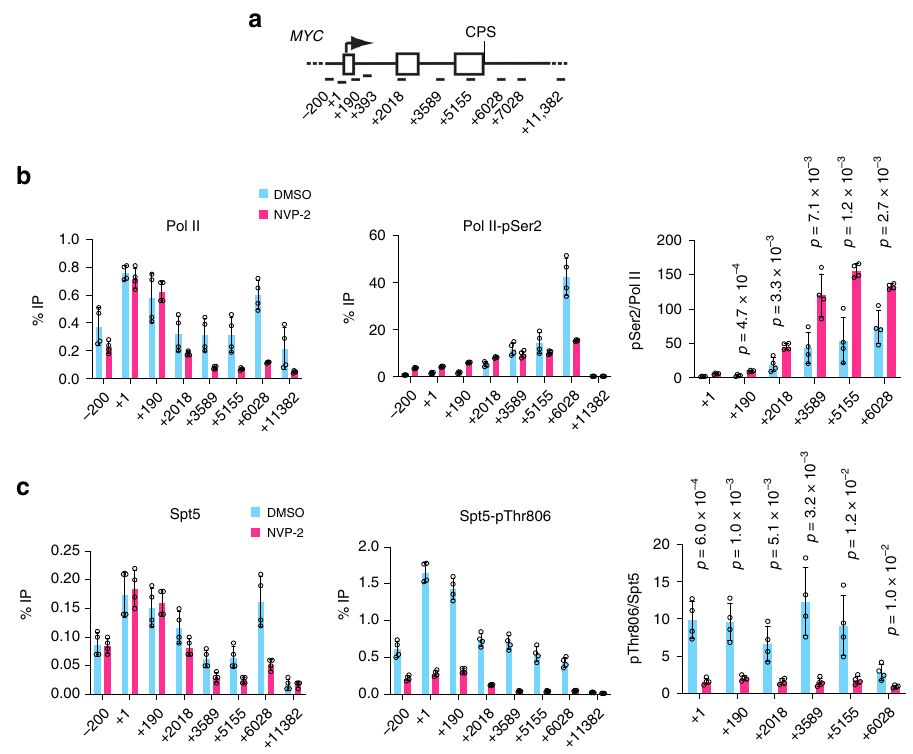
Fig. 3 Cdk9 inhibition diminishes Spt5-pThr806 but increases Pol II-pSer2 on chromatin. a Schematic of the MYC gene, indicating positions of primer pairs used in ChIP-qPCR analysis. b ChIP-qPCR analysis of total Pol II and CTD-Ser2 phosphorylation in HCT116 cells treated with NVP-2 (250 nM) or mock treated (DMSO) for 1 h. c ChIP-qPCR analysis of total Spt5 and Spt5-Thr806 phosphorylation in HCT116 cells treated with NVP-2 (250 nM) or mock treated (DMSO) for 1 h. Individual data points from four biological replicates ( n = 4) are shown; indicated p values were calculated using two-sided Student ’ s t test; error bars indicate ±s.d. from mean ( b and c ). Source data are provided as a Source data fi